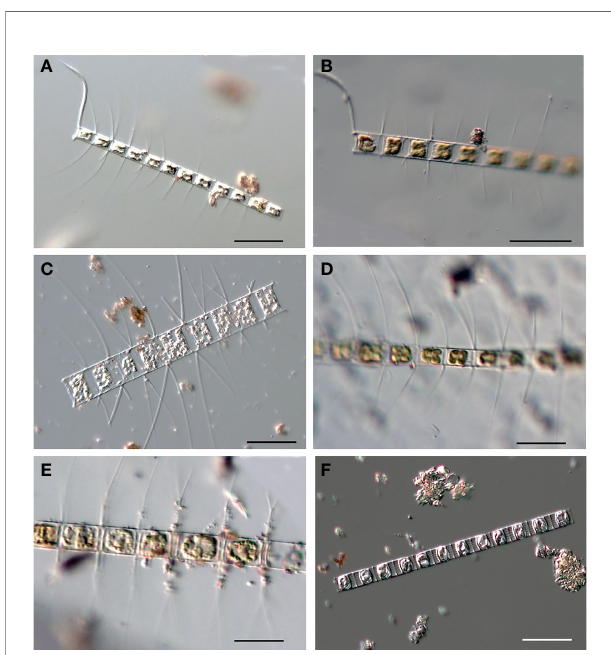
FIGURE 9 | Photomicrographs, as examples, of the diatoms forming long chains observed in the fl occulent layer of the sediment core sample collected at the PET chamber experiment site in Ago Bay. Chaetoceros af fi nis (A, B) , Chaetoceros lorenzianus (C) , Chaetoceros compressus (D) , Bacteriastrum sp. (E) , Skeletonema sp. (F) . Scale bars: 50